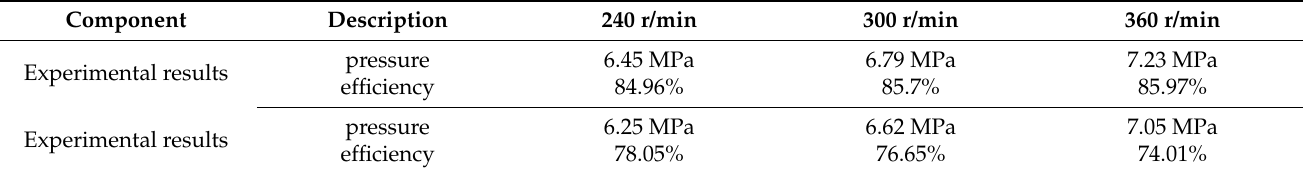
Table 2. Final pressure and energy recovery efficiency of the accumulator at various speeds.